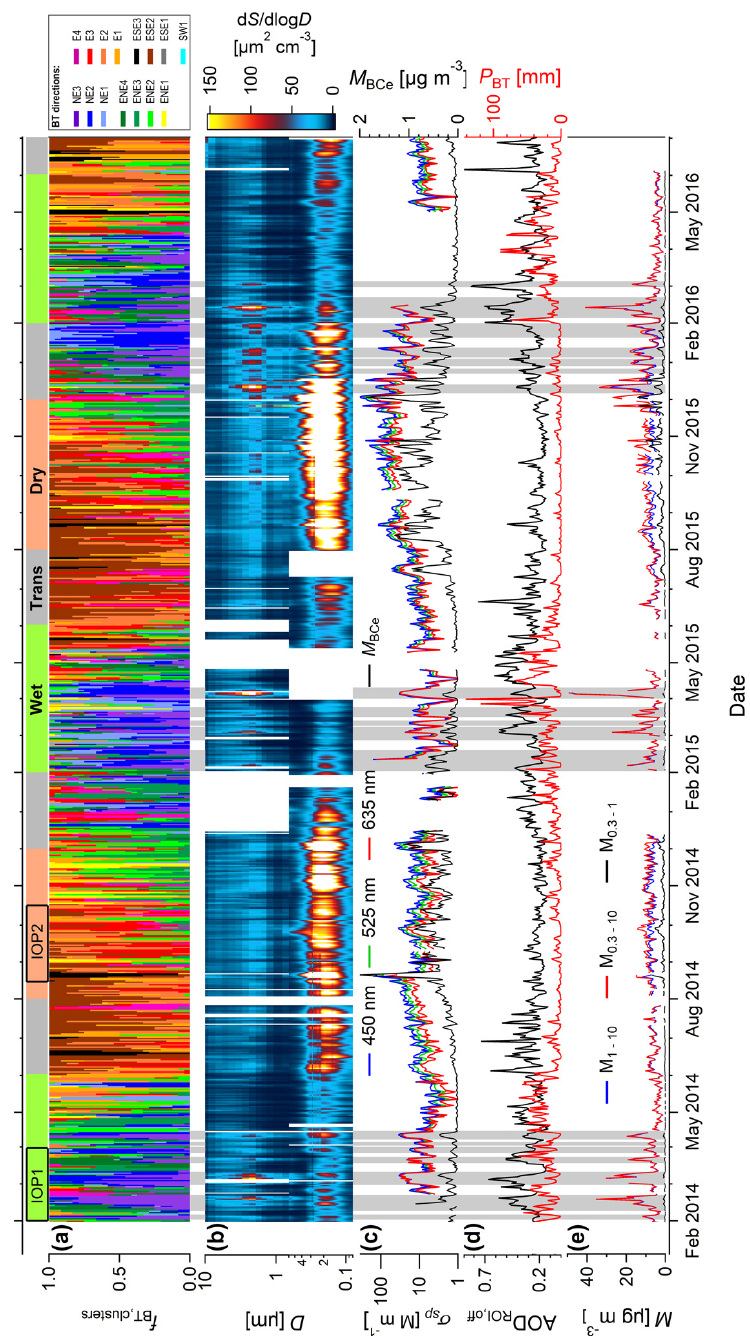
Figure 2. Overview of the long-term meteorological and aerosol time series emphasizing coarse mode data, in the context of atmospheric seasonality at the ATTO site, with time series representing daily averages. (a) Frequency of occurrence, f BT , clusters , of 15 back trajectory clusters as displayed in Fig. S4 (with identical color coding). (b) Image plot of aerosol surface size distribution for the size range from 80nm to 10µm. ( c , left axis) Time series of the aerosol scattering coefficients, σ sp , at three different wavelengths. ( c , right axis) Time series of equivalent black carbon (BC e ) with mass absorption cross-sections (MAC) at 637nm that represent conditions in the ATTO region (wet season: 11.4m 2 g − 1 ; dry season: 12.3m 2 g − 1 ). ( d , left axis) Satellite-retrieved aerosol optical depth at 550nm, area-averaged over offshore region of interest (ROI off , see Fig. S4). The AOD ROI , off time series represents the average of the MODIS data sets from the satellites Aqua and Terra ( d , right axis) HYSPLIT-retrieved accumulated precipitation P BT along the trajectory tracks. (e) Aerosol mass concentrations in the size ranges 0.3–10µm ( M 0 . 3 – 10 ), 1–10µm ( M 1–10 ), and 0.3–1µm ( M 0 . 3 – 1 ). Colored shading in the top of the figure visualizes the Amazonian seasons (see Sect. 2.10) as well as the intensive operation periods (IOPs) 1 and 2 of the GoAmazon2014/5 project. Gray vertical bands mark episodes when Saharan LRT aerosol was measured at the ATTO site (see Table